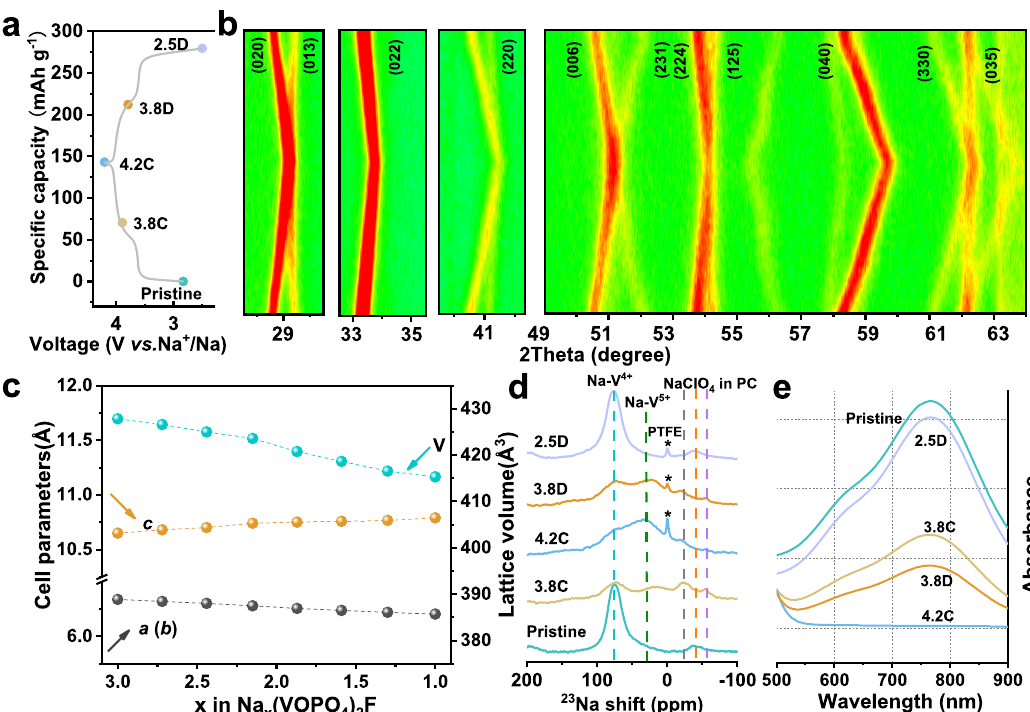
Fig. 4 Crystal structure evolution of NVOPF/8%KB cathode. a The charge – discharge curves of NVOPF/8%KB at a current rate of 0.1C in in situ XRD experiment. b The in situ XRD patterns. c The variation of cell parameters during the charging process. d High-resolution 23 Na SSNMR spectra of NVOPF/ 8%KB electrode under various states. e Ex situ UV-vis spectra of the NVOPF/8%KB